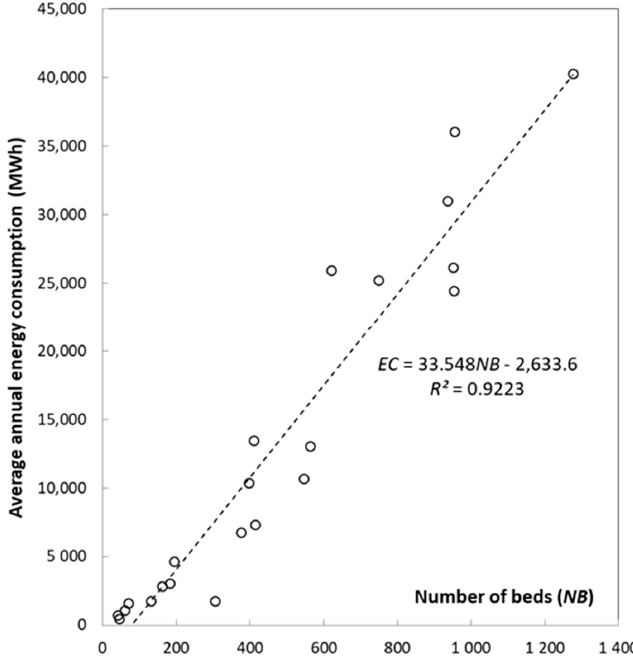
Figure 5. The ratio of average annual energy consumption and number of beds per hospital.